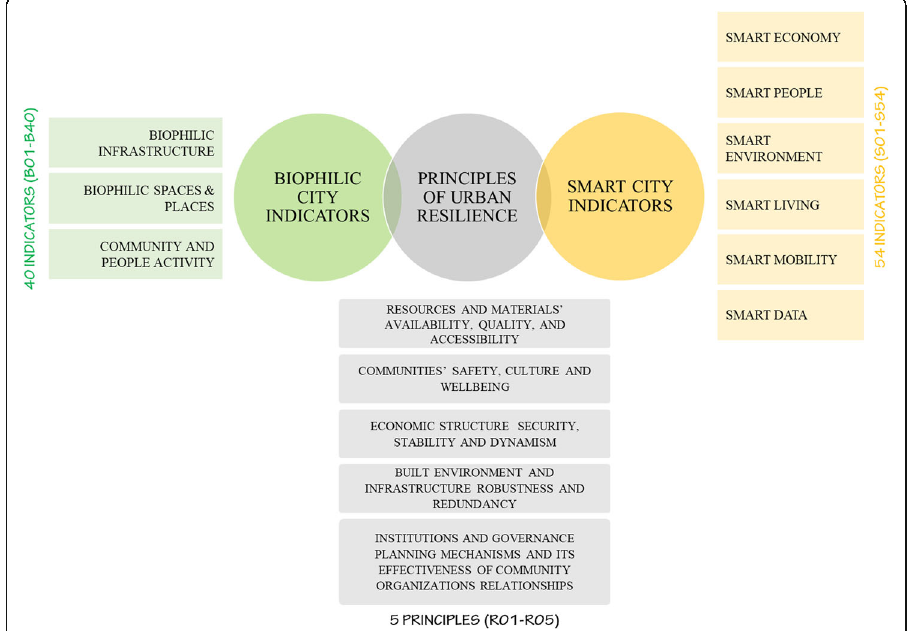
Fig. 4 Achieving urban resilience through biophilic and smart approaches